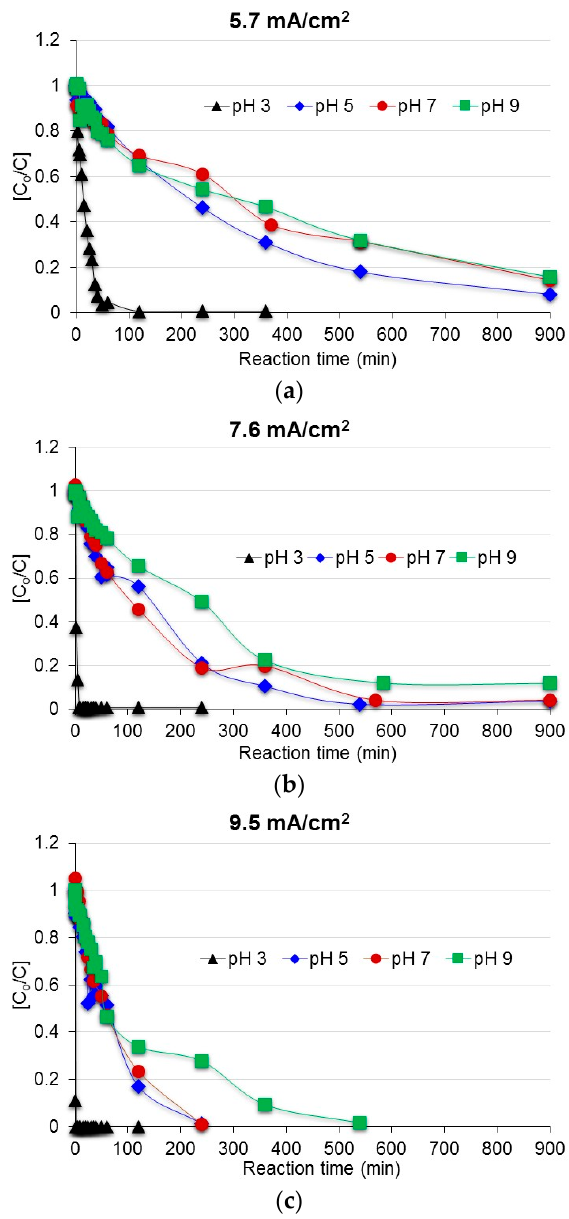
Figure 2. Decay of the acetaminophen at different pH values and current densities. ( a ) DC density: 5.7 mA/cm 2 ; ( b ) DC density: 7.6 mA/cm 2 ; ( c ) DC density: 9.5 mA/cm 2 .